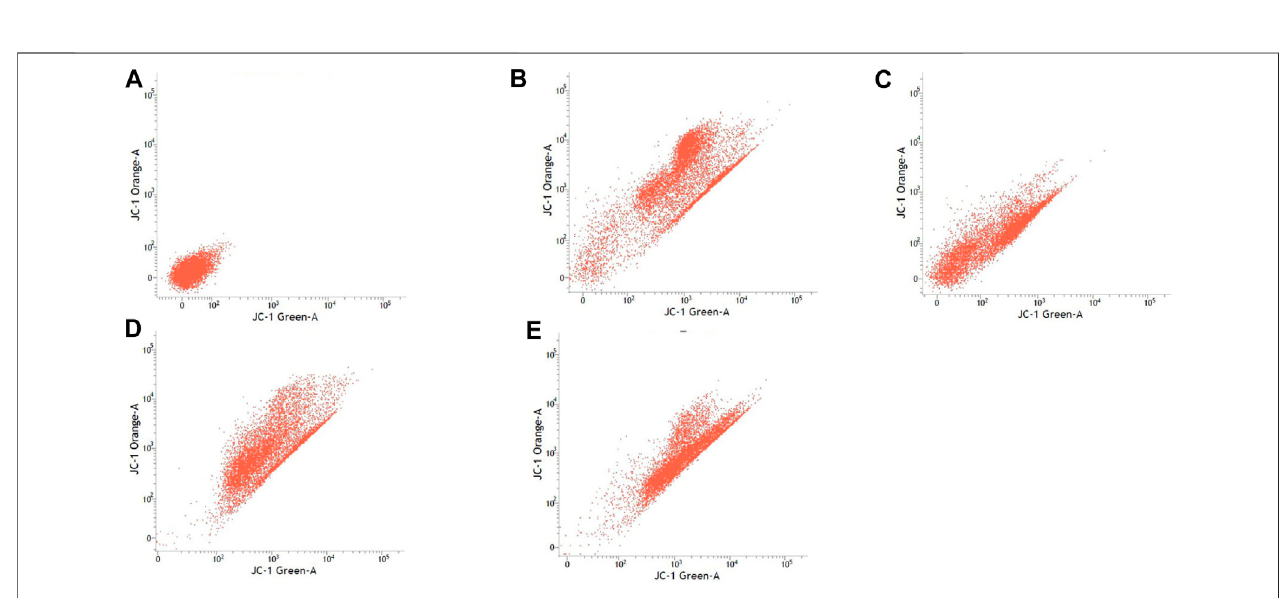
FIGURE 6 | PC-12 cell lines with or without treatment with sialic acid using JC-1 Mito Probe by BD FACSAria ™ : (A) untreated cell; (B) control without CCP; (C) control with CCP; (D) treatment with standard sialic acid; (E) treatment with extraction of sialic acid.